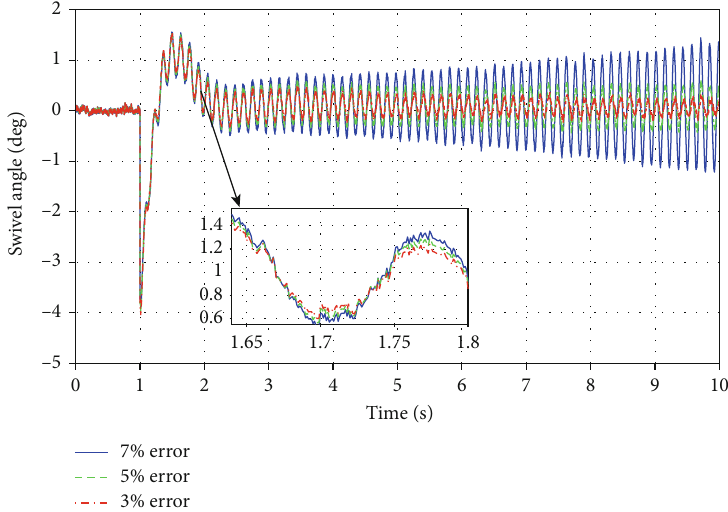
Figure 18: Swivel angle curve of di ff erent FBG average